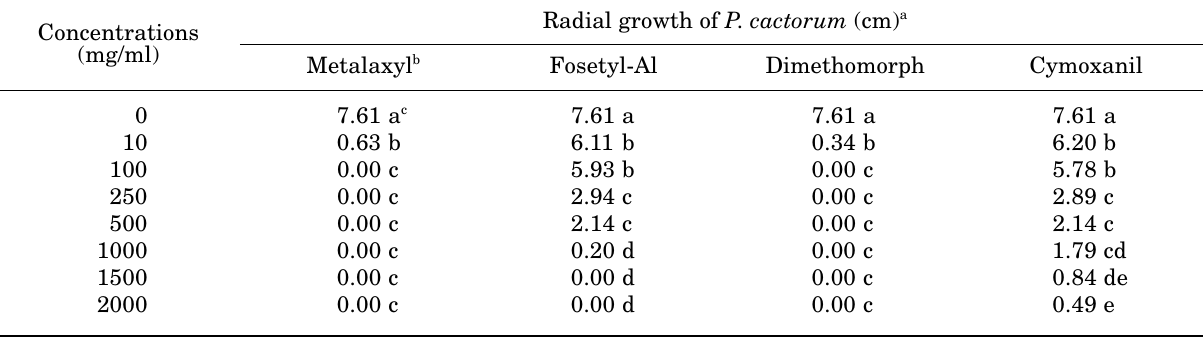
Table 1. Effect of metalaxyl, fosetyl-Al, dimethomorph and cymoxanil at various concentrations on radial growth of Phytophthora cactorum in